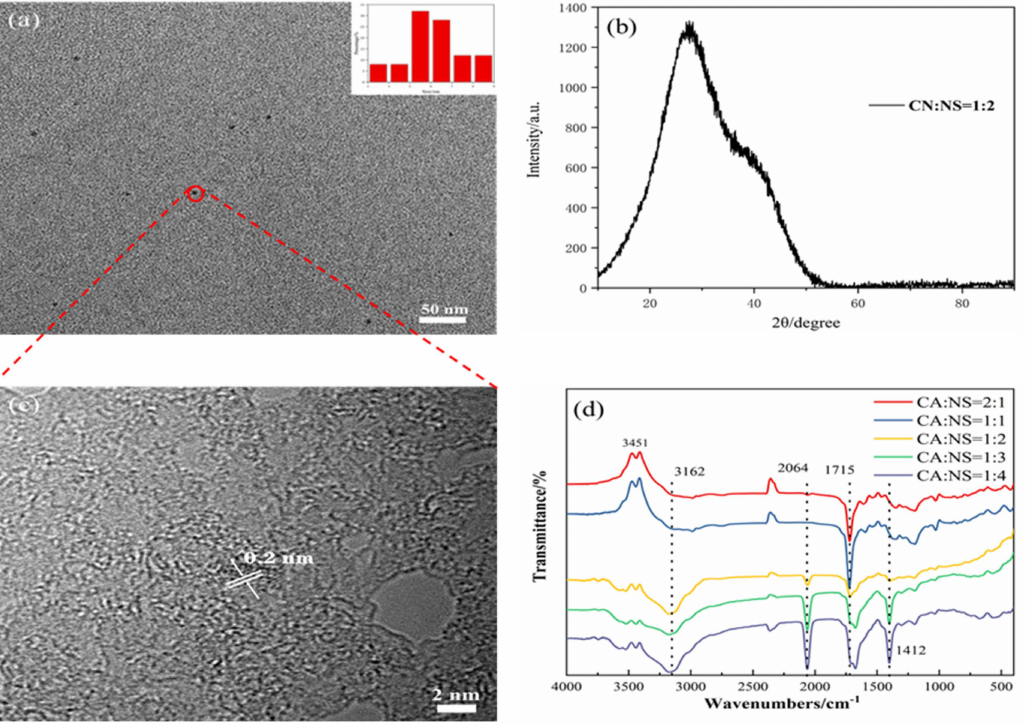
Figure 2. TEM and particle size distribution ( a ), XRD ( b ), lattice spacing ( c ), and IR spectrum ( d ) of